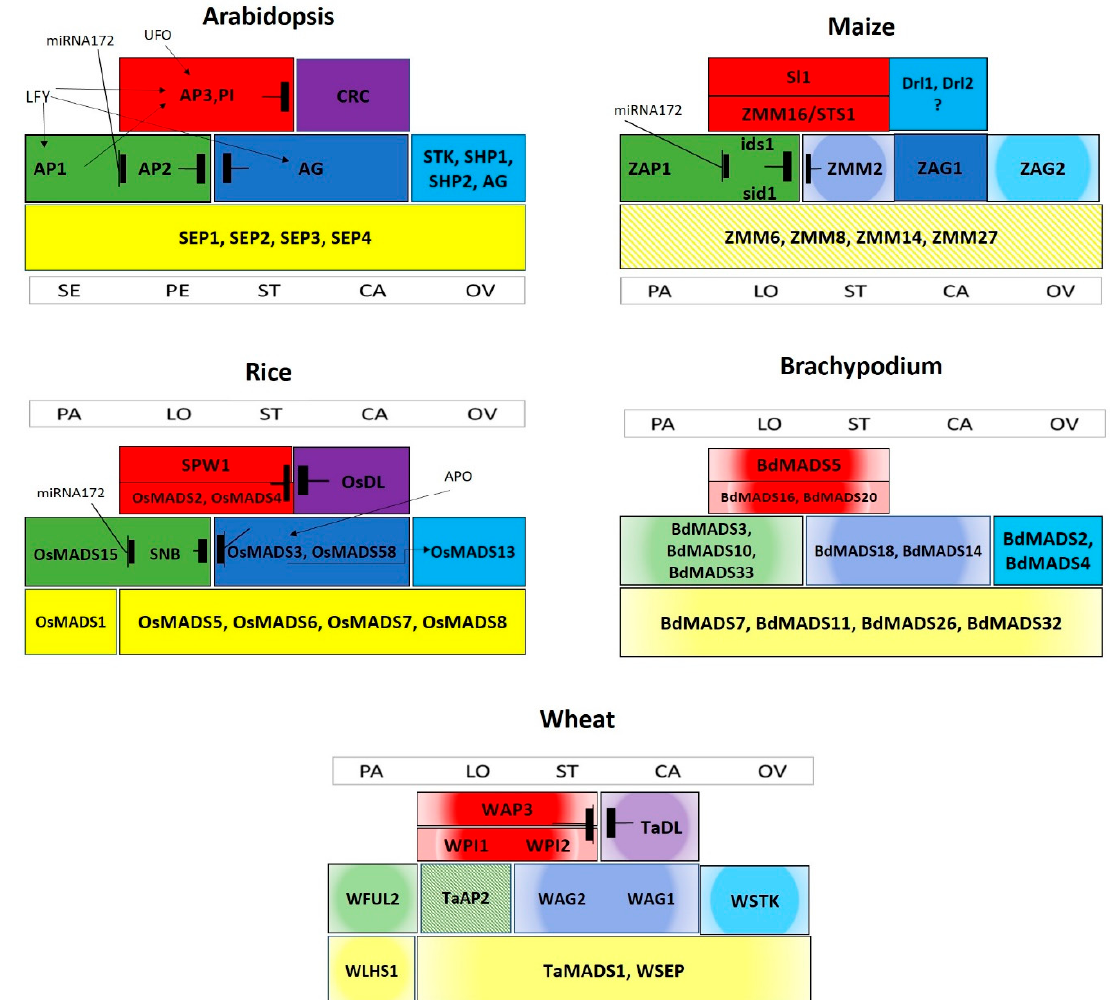
Figure 2. ABCDE models of floral organ identity. Revised floral organ identity models in Arabidopsis, rice, maize, Brachypodium, and wheat. Class (A)-genes indicated in green, class B in red, class C in dark blue, class D in light blue, class E yellow, and non-MADS in purple. Solid colors show functional data, color gradients represent expression analysis data, while color patterns indicate hypothesized functions. Antagonistic interactions are indicated with barred lines, black arrows illustrate positive regulation of the corresponding genes, and a comma symbolizes duplicated gene interaction. Abbreviations: CA: Carpel; LO: Lodicule; OV: Ovule; PA: Palea; PE: Petal; SE: Sepal; ST: Stamen. For gene abbreviations see text.